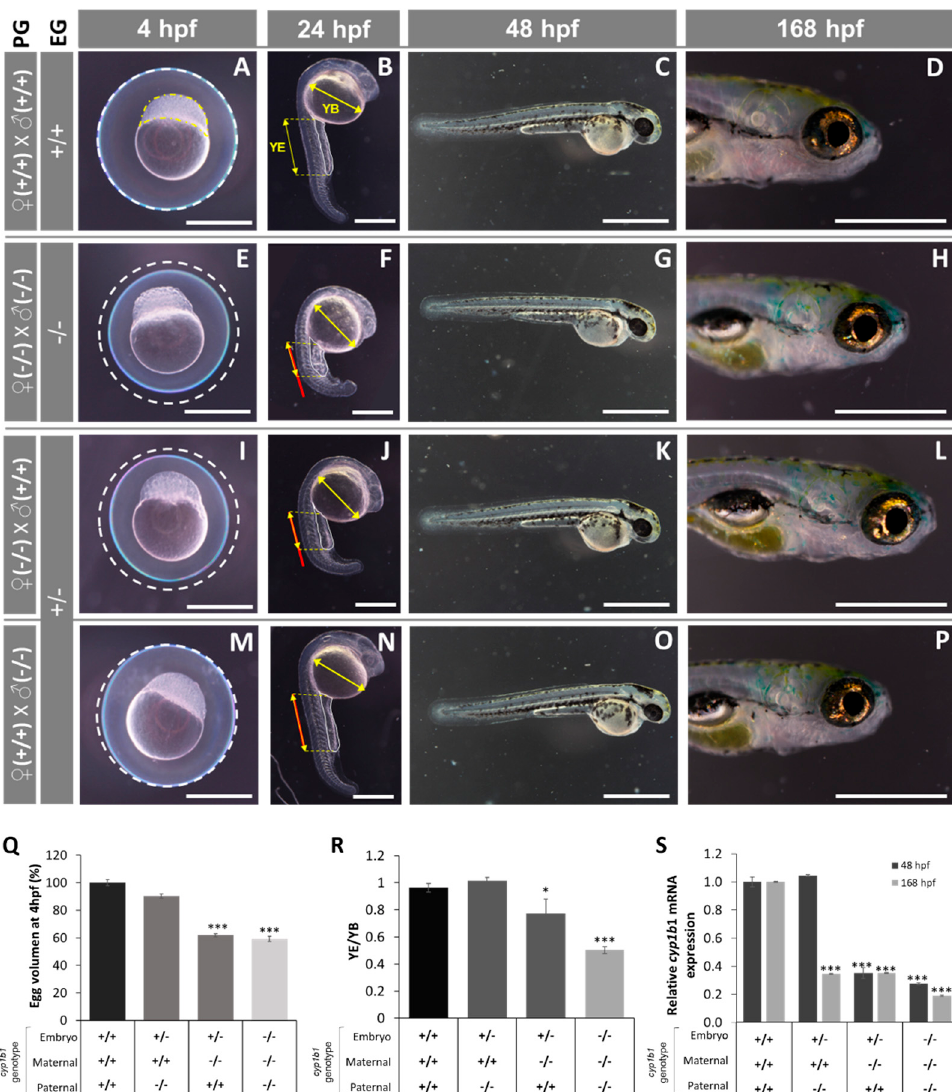
Figure 4. Early (4 -168 hpf) phenotypes of the established cyp1b1 -KO zebrafish line. ( A – P ) The phenotypes were analyzed in F4 zebrafish resulting from inbreeding of young (<six months) F3 siblings. Progenitors’ genotypes (PG) and embryos’ genotypes (EG) are indicated on the left. ( A , E , I , M ) The difference in egg volume (white dotted line). Yellow dotted line: animal pole. ( B , F , J , N ) The differences in yolk extension (YE) length and yolk ball’s (YB) largest diameter. Red line: wildtype YE length extrapolated to embryos with different genotypes. No differences were observed in larval development at 48 hpf and 168 hpf. The images are representative of the results observed in at least 10 embryos per experimental group. Scale bars represent 500 µ m in 4 hpf, 24 hpf and 168 hpf photographs and 1000 µ m in 48 hpf photographs. ( Q ) Relative egg volume at 4 hpf. The values are expressed as the percentage of the volume of wildtype eggs ( n = 20). ( R ) YE/YB ratio at 24 hpf ( n = 3–6). ( S ) Cyp1b1 mRNA levels in zebrafish at 48 hpf and 168 hpf. Pools of 45 F4 zebrafish at 48 and 168 hpf were used to calculate cyp1b1 mRNA levels by RT-qPCR. The values are expressed as in triplicate were used for calculation of mean expression values in each sample. Asterisks